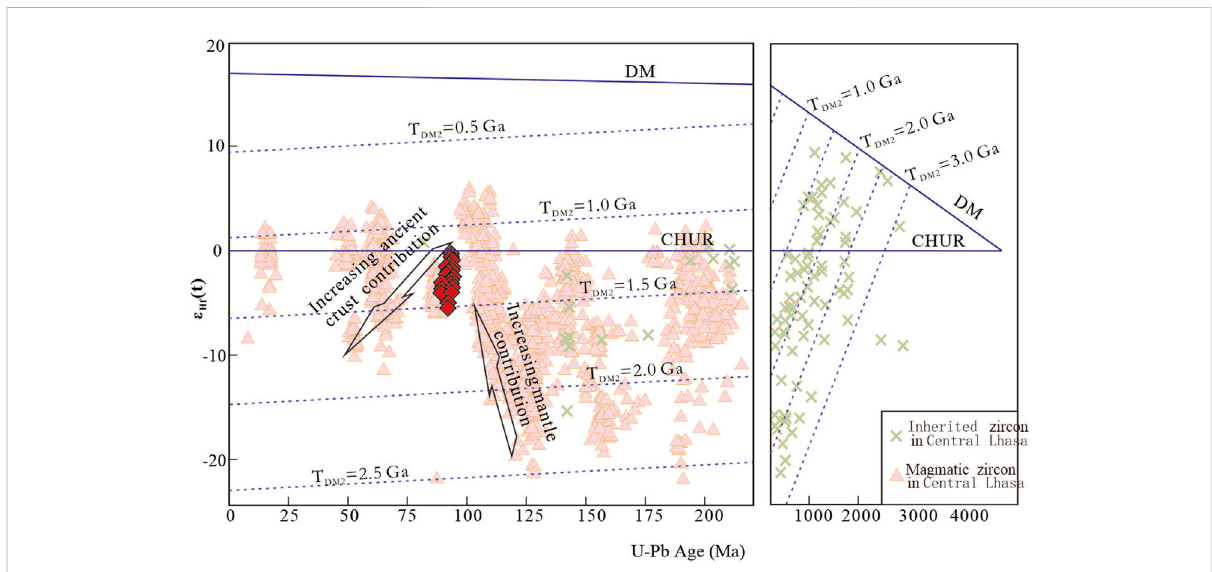
FIGURE 6 ε Hf (t) vs. U-Pb ages Plots of zircons. (The Central Lhasa values from Yu et al., 2011; Wang et al., 2012; Meng et al., 2014; Hou et al., 2015; Zhao et al., 2011; Liu et al., 2018a; Cao et al., 2019; DM: Depleted Mantle; CHUR: Chondrite uniform reservoir).